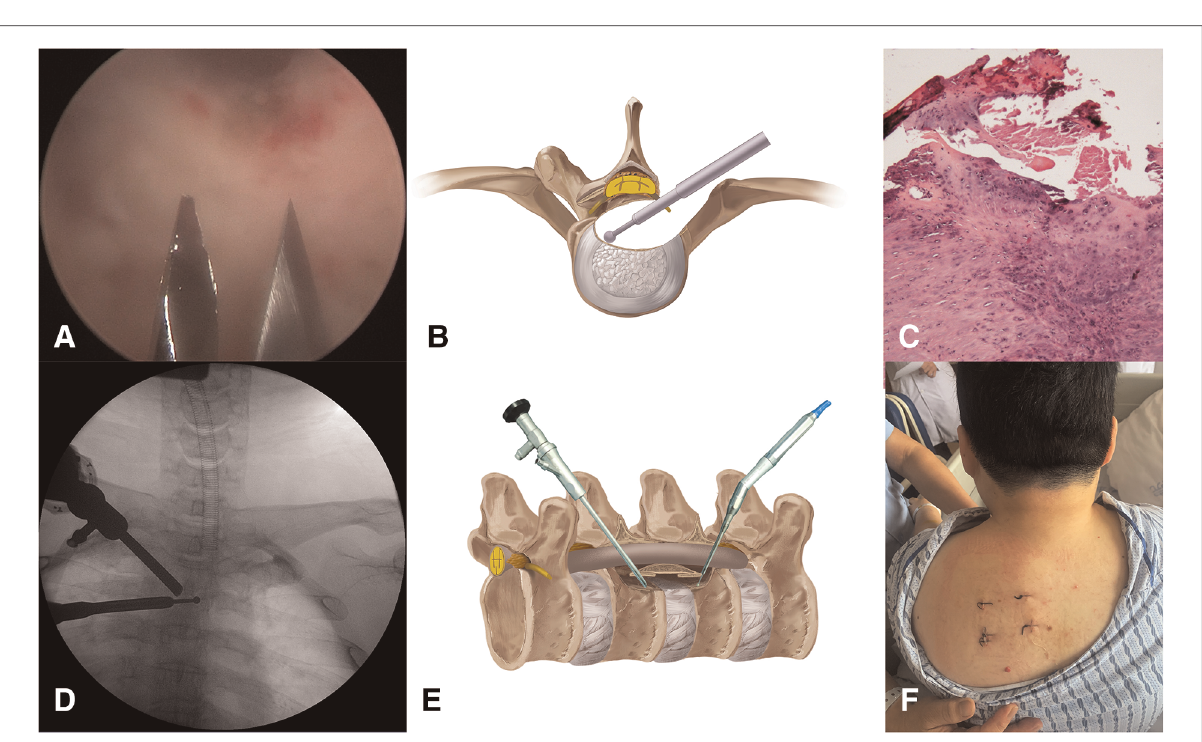
FIGURE 4 ( A ) Create portals C and D under direct endoscopy view. ( B,E ) Illustration of the “ cave ” boundaries created by the grinding burr. ( C ) Pathological image of the removed OPLL. ( D ) The grinding burr has reached the medial wall of the pedicle conformed by C-arm. ( E ) Skin incisions of the four